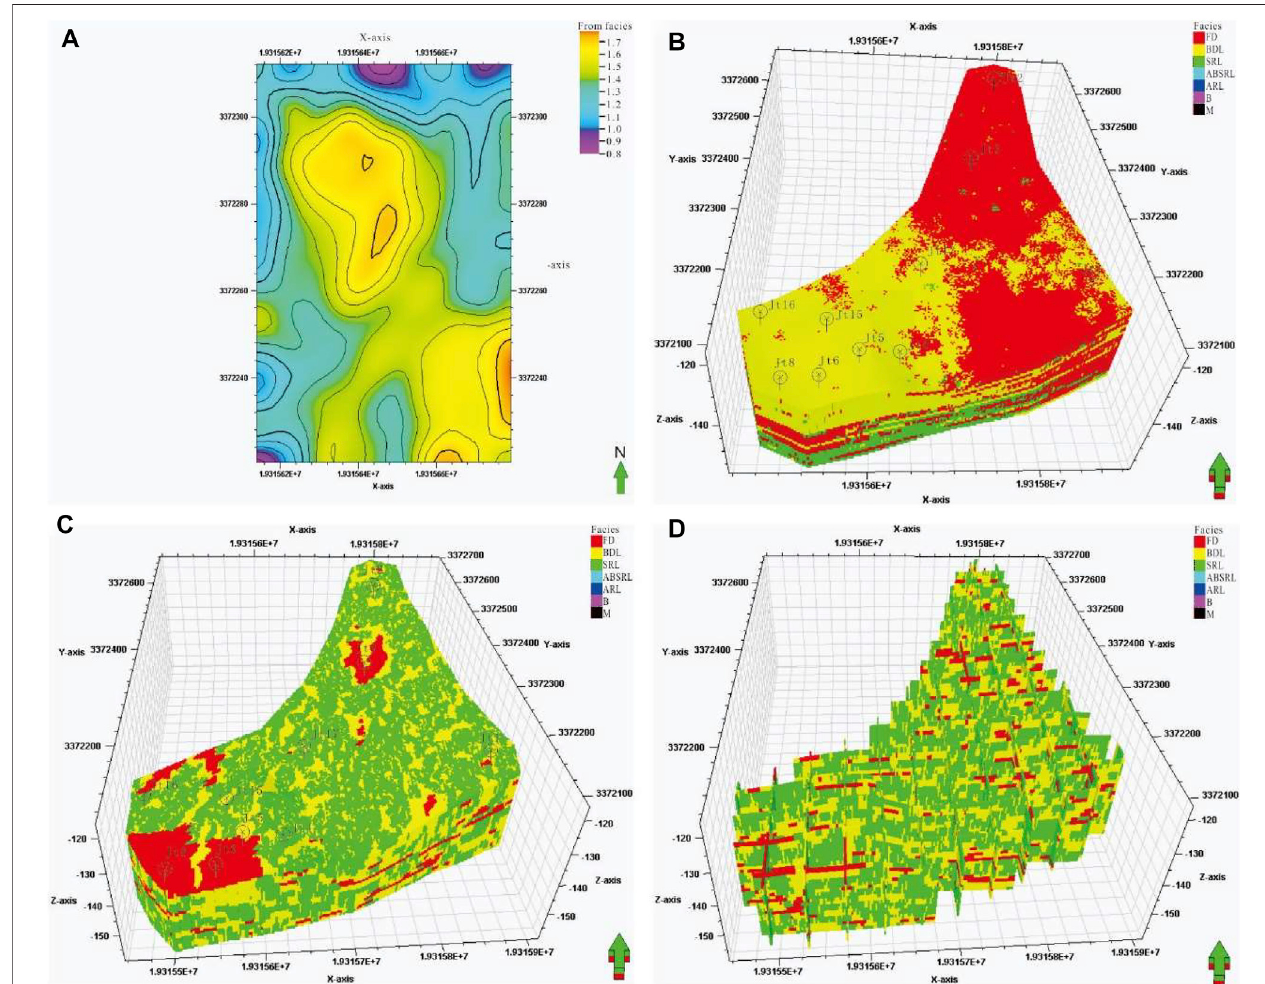
FIGURE15| 3-Doutcropmodelingofreefcrestmicrofacies,whicharerestraintbytrainingimagepattern. (A) Reefcresttrainingimage,whichdepositedcarbonate lithofacies but very poor continuity; (B) the SIS lithological modeling; (C) MPS realization; (D) palisade 3-D grids display about the multipoint geostatistics model.